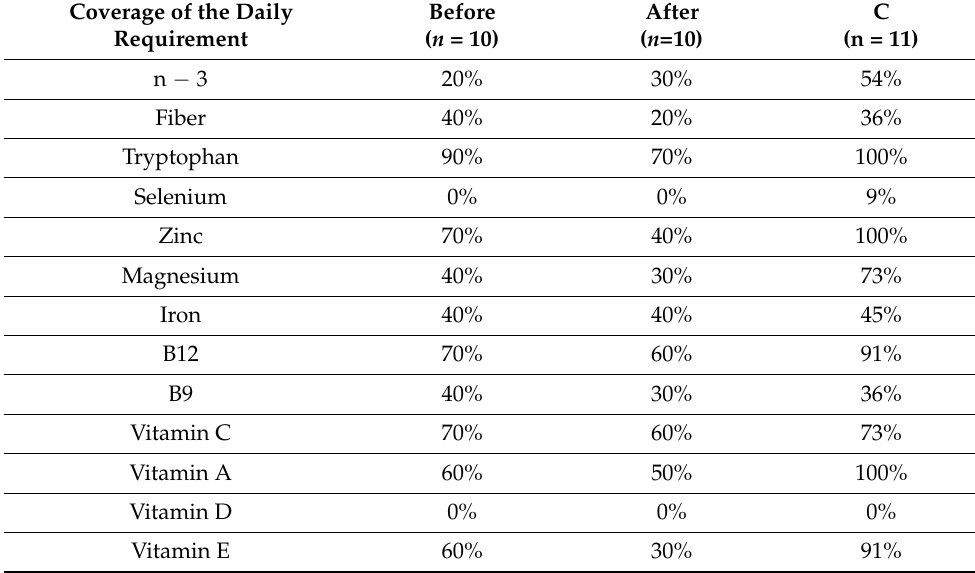
Table 4. Coverage of the daily requirements for individual nutrients by